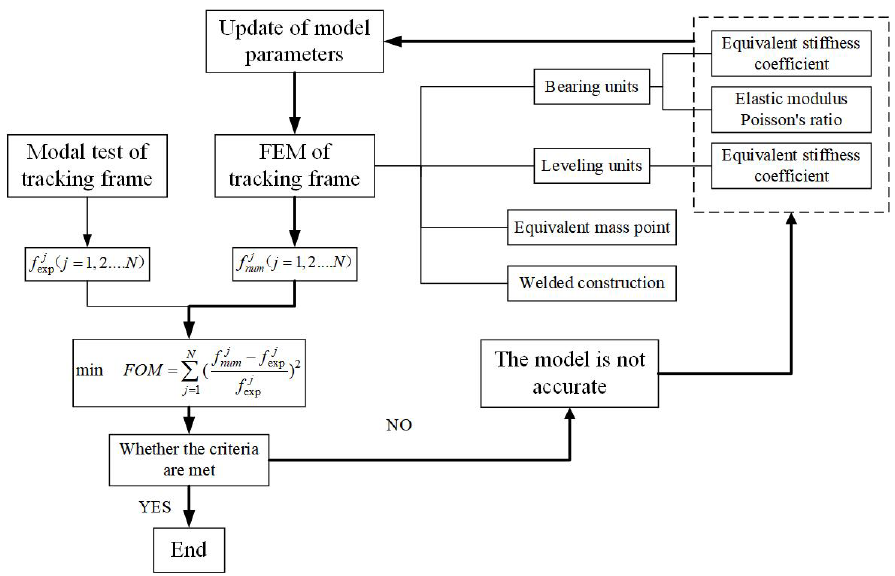
Figure 2. Diagram of the calculation strategy employed in this paper.